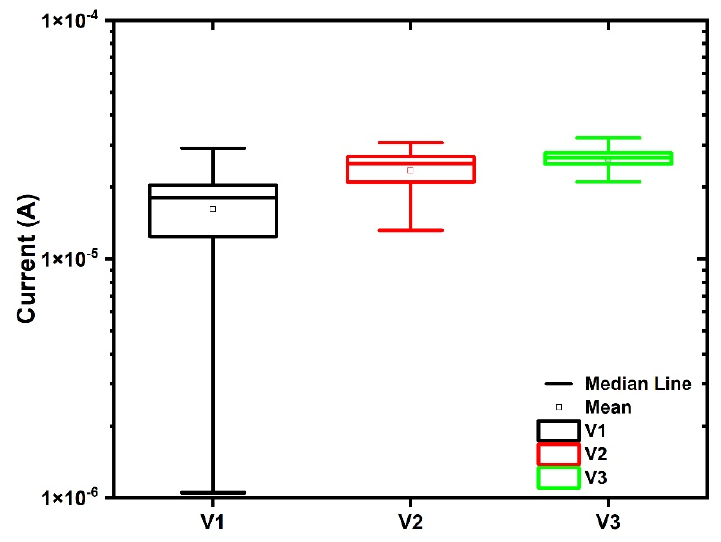
Figure 7. LRS currents extracted from DC set operations of V1, V2 and V3 memristive devices.